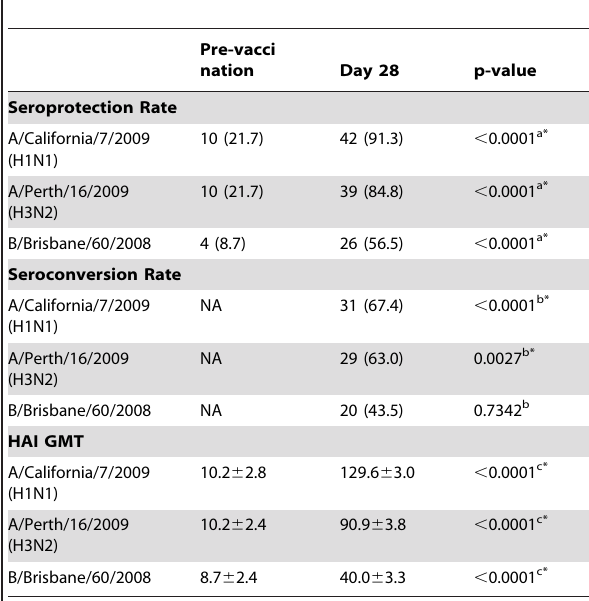
Table 2. Seroprotection rate, seroconversion rate, and HAI GMT of 46 subjects at day 28 after